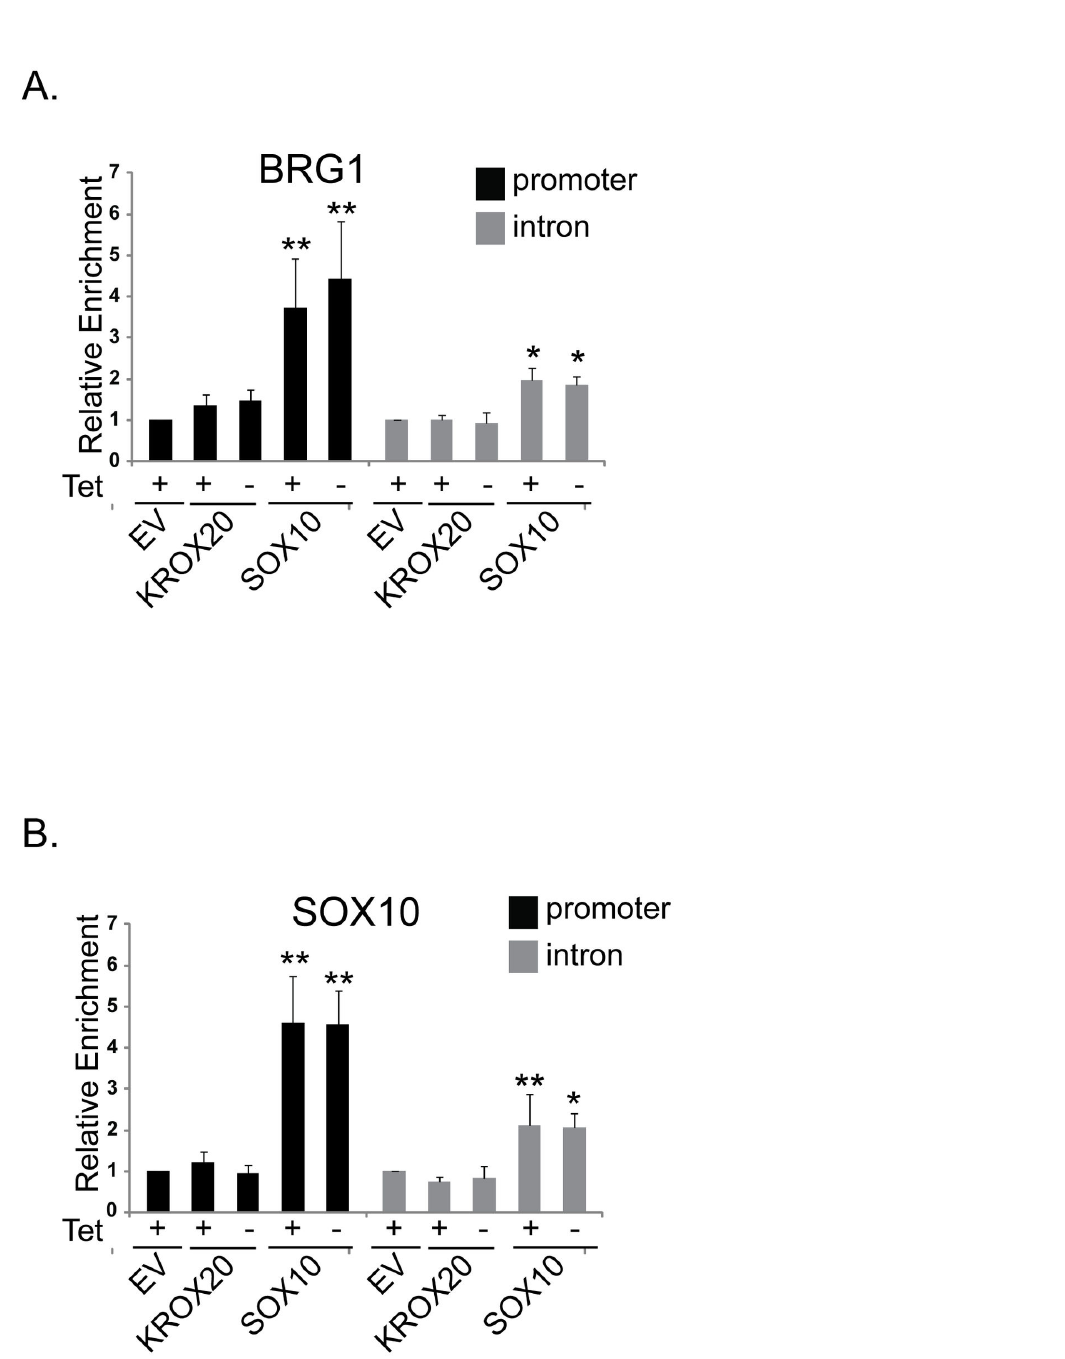
Figure 4. BRG1 is recruited to the MPZ promoter as a result of SOX10 mediated differentiation. Chromatin immunoprecipitations (ChIPs) were performed with control IgG, antisera to BRG1, or an antibody to SOX10 on chromatin from B22 cells that were infected with empty vector (EV), KROX20, or SOX10 retrovirus and cultured as described in Figure 1. Enrichment at the MPZ promoter and intron is relative to control IgG and normalized to a control region, SCN2A1. There was minimal variation in the ChIP signal at the SCN2A1 region. (A) Detection of BRG1 interactions with the MPZ promoter and intron. (B) Detection of SOX10 interactions with the MPZ promoter and intron. This data are representative of at least three experiments and are the average of two independent experiments that were assayed four or more times, each in triplicate. Standard errors bars and statistical significance are shown (**p<0.01, * p<0.05). doi: 10.1371/journal.pone.0069037.g004 PLOS ONE |